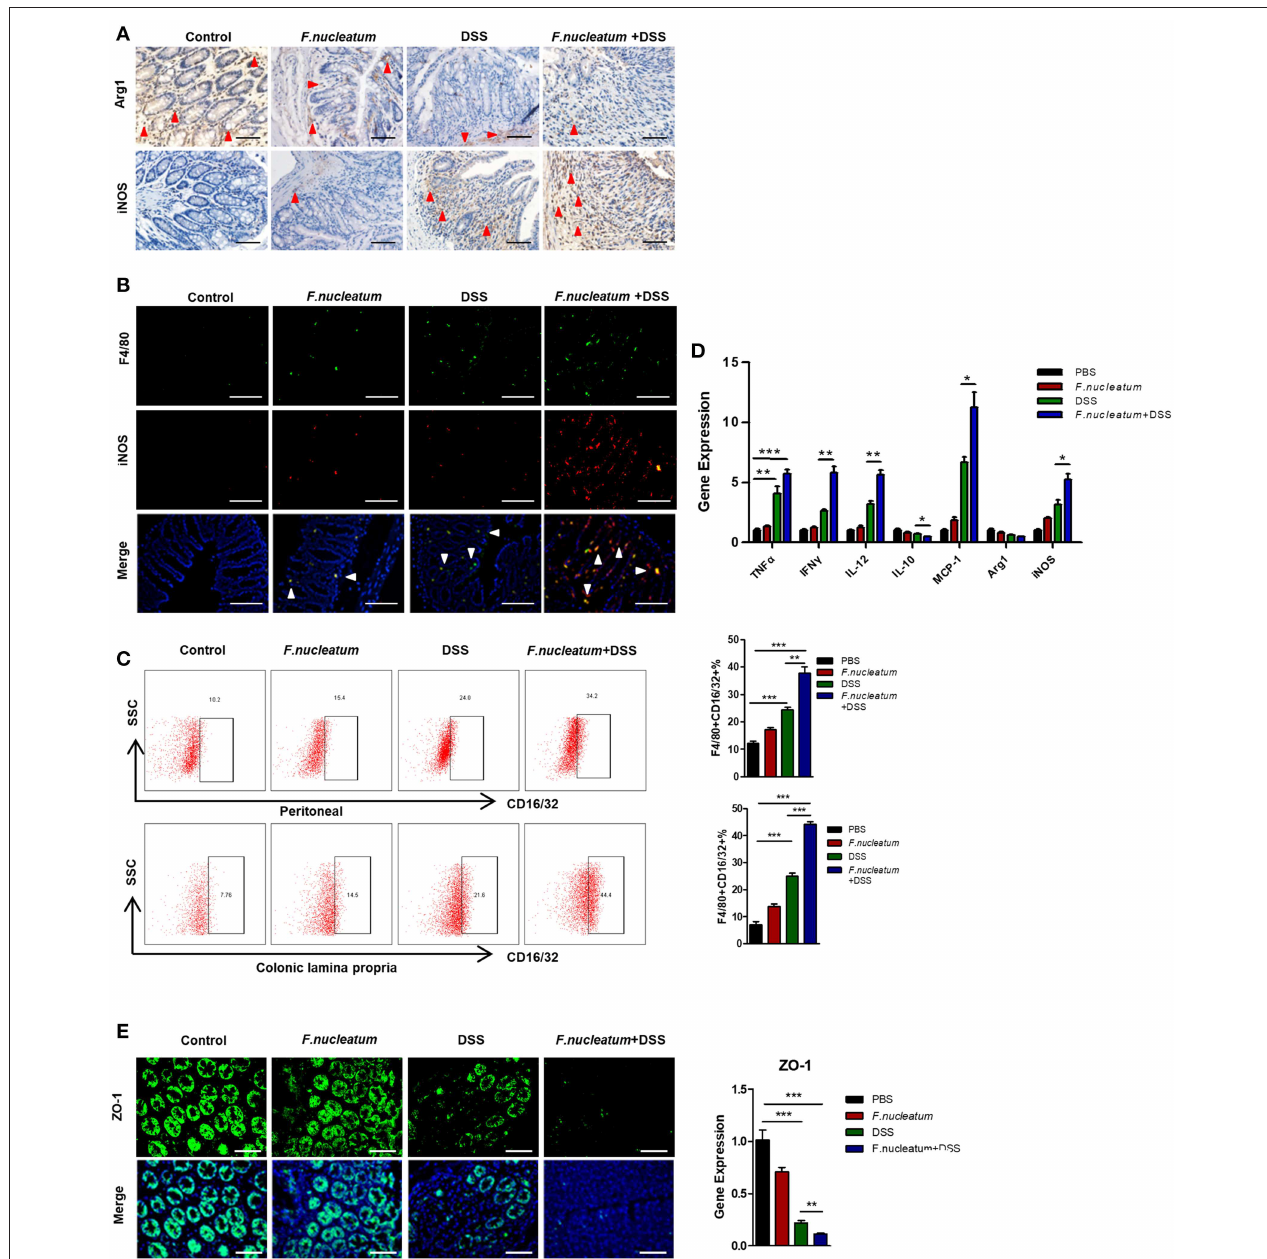
FIGURE 3 | F. nucleatum induces M1 macrophage infiltration and activation in colitic mice. (A) Representative images of colon Arg1 and iNOS levels measured by IHC. Scale bars, 25 µ m. (B) Sections of colon tissues were immunostained with F4/80 (green) and iNOS (red) macrophages; DAPI (blue) served to stain nuclei. Representative images are shown. Scale bars, 50 µ m. (C) Peritoneal and LP cells were stained with F4/80 and CD16/32 and assessed by flow cytometry. The ratios of F4/80 and CD16/32 positive cells are shown. (D) TNF- α , IFN - γ , IL-12, IL-10, MCP-1, Arg-1, iNOS, and ZO-1 were measured by qRT-PCR in colon tissue samples. (E) Sections of colon tissues were immunostained with ZO-1 (green) and DAPI (blue) from each group. Representative images are shown. Scale bars, 10 µ m. Each experiment was performed at least three times. Data are presented as means ± SD. * P < 0.05; ** P < 0.01; *** P < 0.001; Analysis of Variance (ANOVA) and Student’s t-test